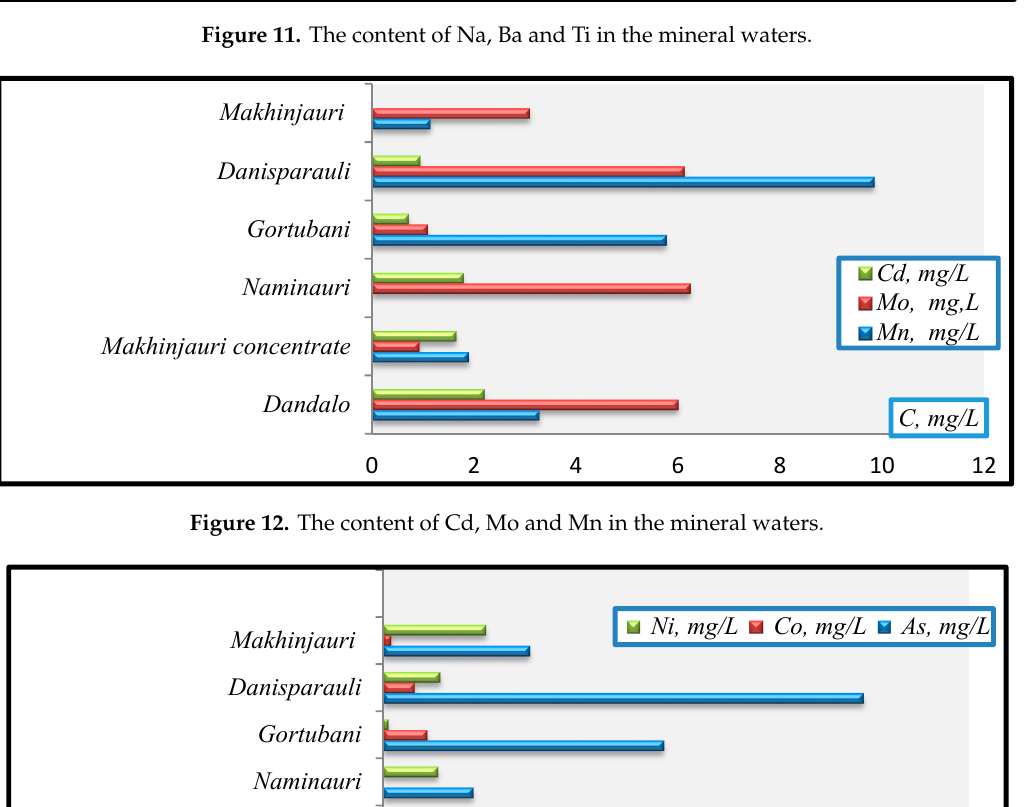
Figure 13. The content of Co, Ni and As in the mineral waters.